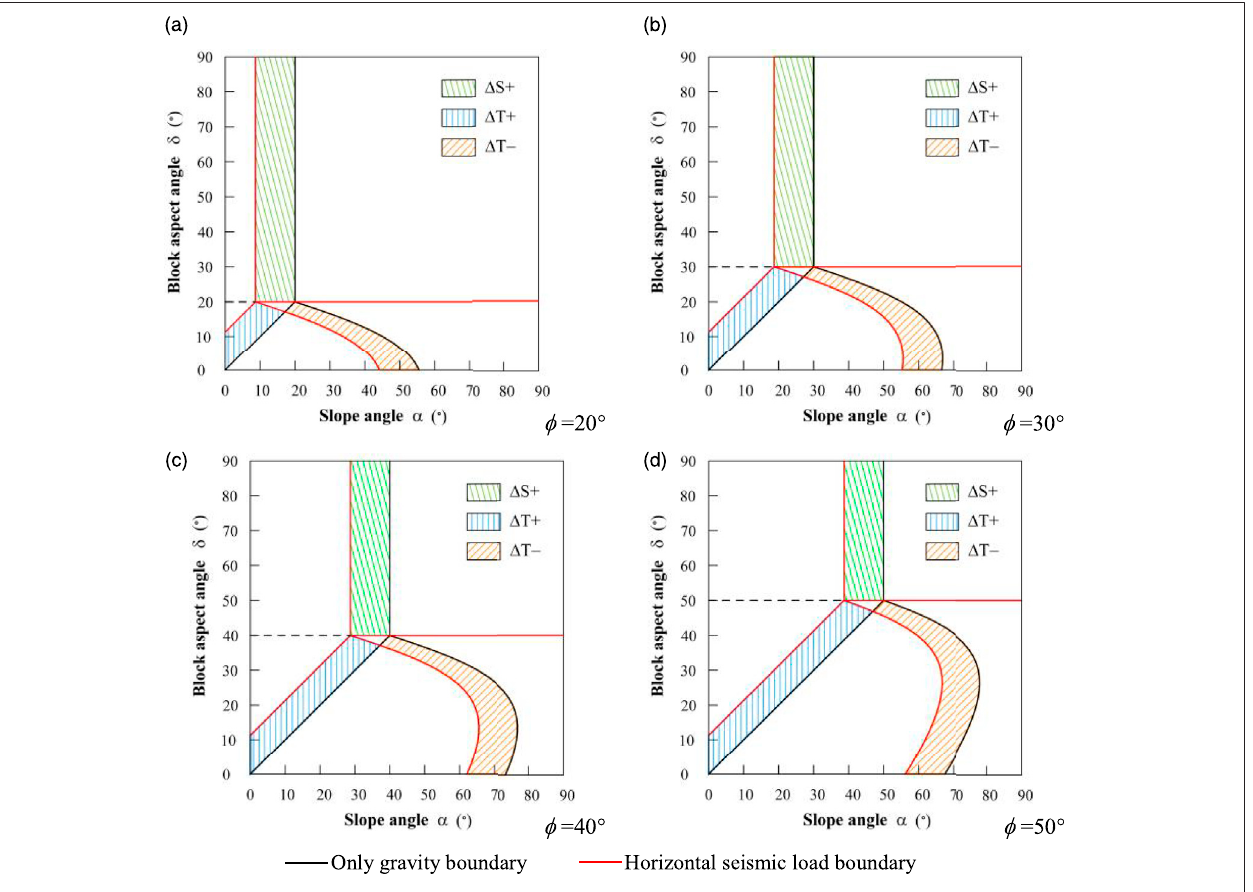
FIGURE 6 | Comparison of instability modes of a single block (F (cid:1) 0.2 mg). (A) ϕ (cid:1) 20 ° , (B) ϕ (cid:1) 30 ° , (C) ϕ (cid:1) 40 ° , (D) ϕ (cid:1) 50 ° .